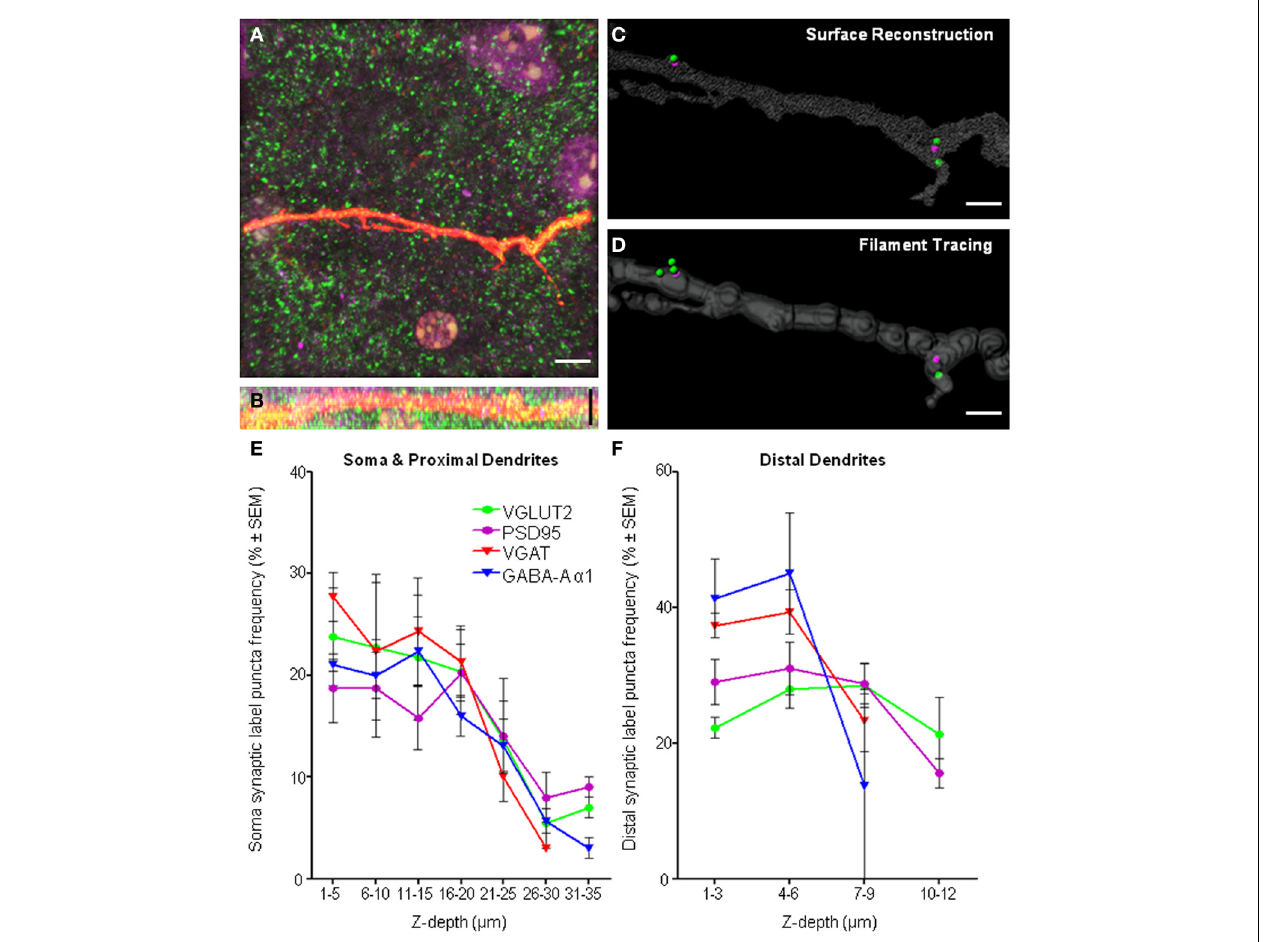
FIGURE 9 | Imaging and methodological considerations. (A) Shows a maximum intensity projection in the xy -axis of a representative distal dendrite (red fluorescence) and excitatory pre-synaptic VGLUT2 (green) and post-synaptic PSD-95 (purple). (B) Shows the same fluorescence in the xz -axis, indicating penetration of all immuno-labeling within dendritic z -stacks. We show the same dendrite with our above method applied to quantify synaptic components using two different methods of defining the dendritic volume, namely, surface reconstruction (C) and filament tracing (D) . We show that equivalent results with regard to synapse quantifications using either surface reconstruction filtering or filament trace filtering. For surface filtering of data, 2 spots internal (PSD-95), 3 spots external (VGLUT2), 2 synapses in total. For filament trace filtering of data, 2 spots internal (PSD-95), 4 spots external (VGLUT2), 2 synapses in total. Frequency histogram analysis of “spot detection” labeling density (%) for all